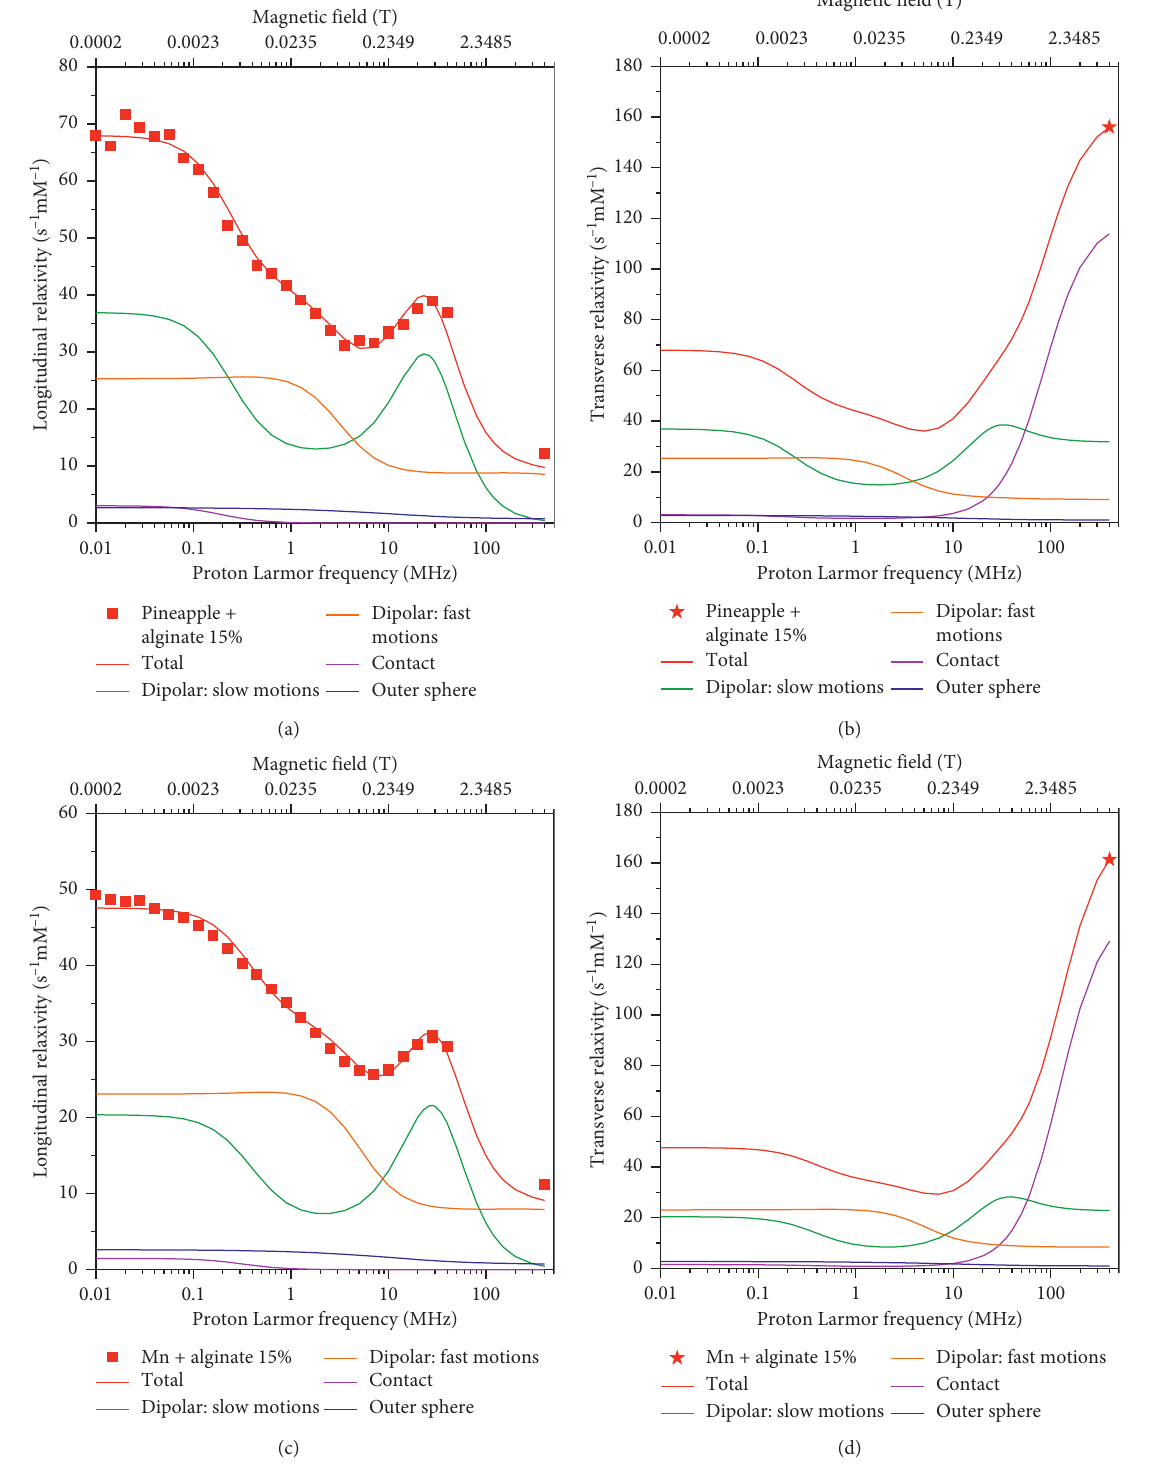
Figure 7: 1 H longitudinal relaxivity (a, c) and transverse relaxivity (b, d) at 25 ° C and their dipolar, Fermi-contact, and outer-sphere contributions in the pineapple juice (a, b) and in the Mn 2+ solution (c, d) upon addition of 15% w/w